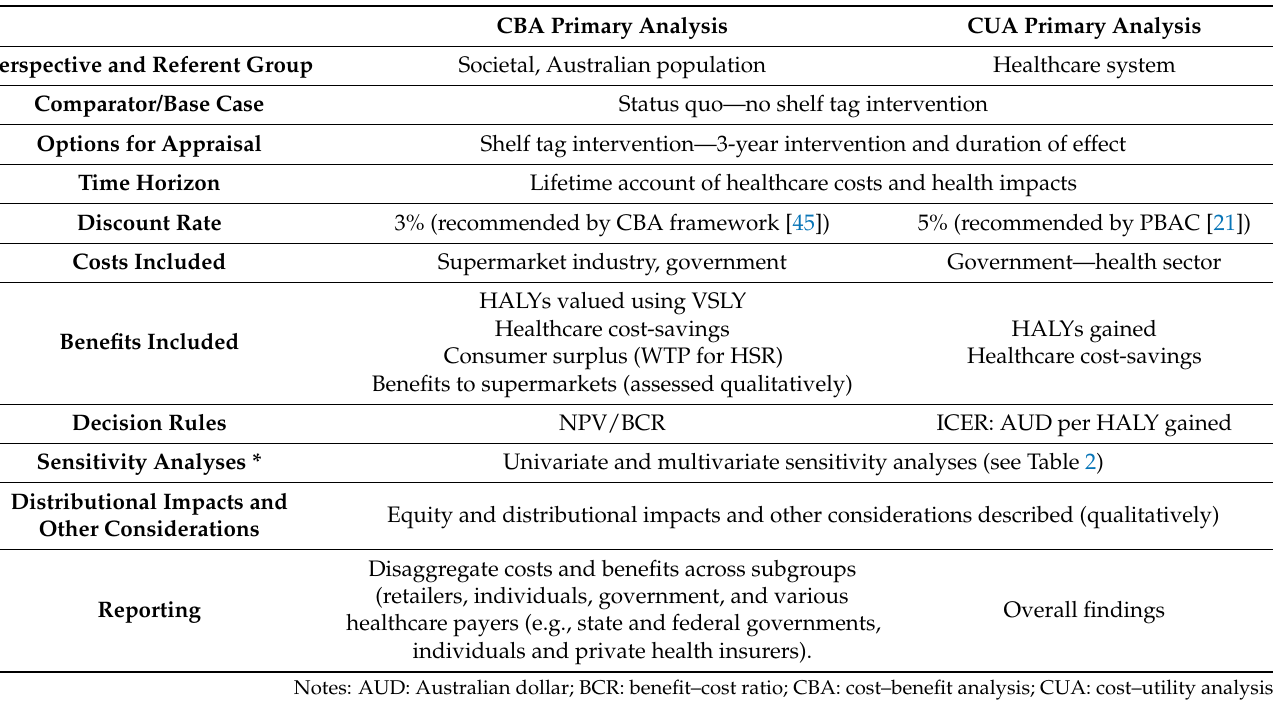
Table 1. Specifications of the primary cost–benefit and cost–utility